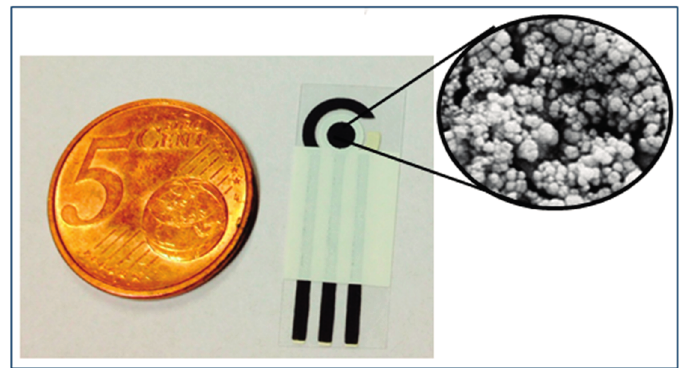
Figure 1. Photo of an SPE modified with PBNPs. Inset: SEM imagine of the working electrode modified with PBNPs (PBNP diameter 95 ± 15 nm). The 5 cent euro coin reference has a diameter of 22.25